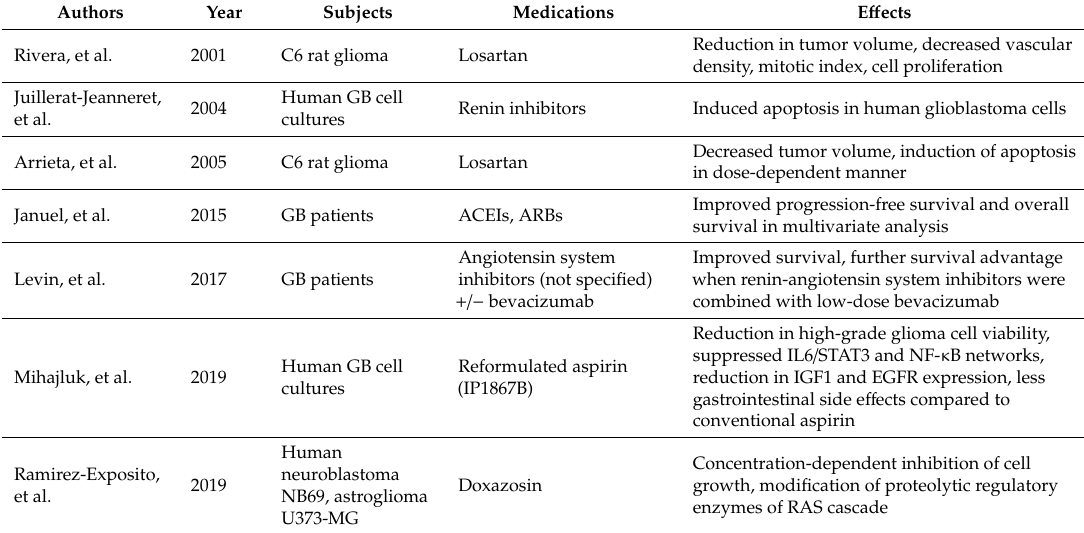
Table 2. Summary of current publications on therapeutic targeting of the RAS in